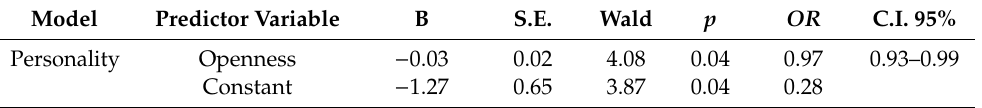
Table 3. Results from the binary logistic regression for the probability of being a cyberbully.